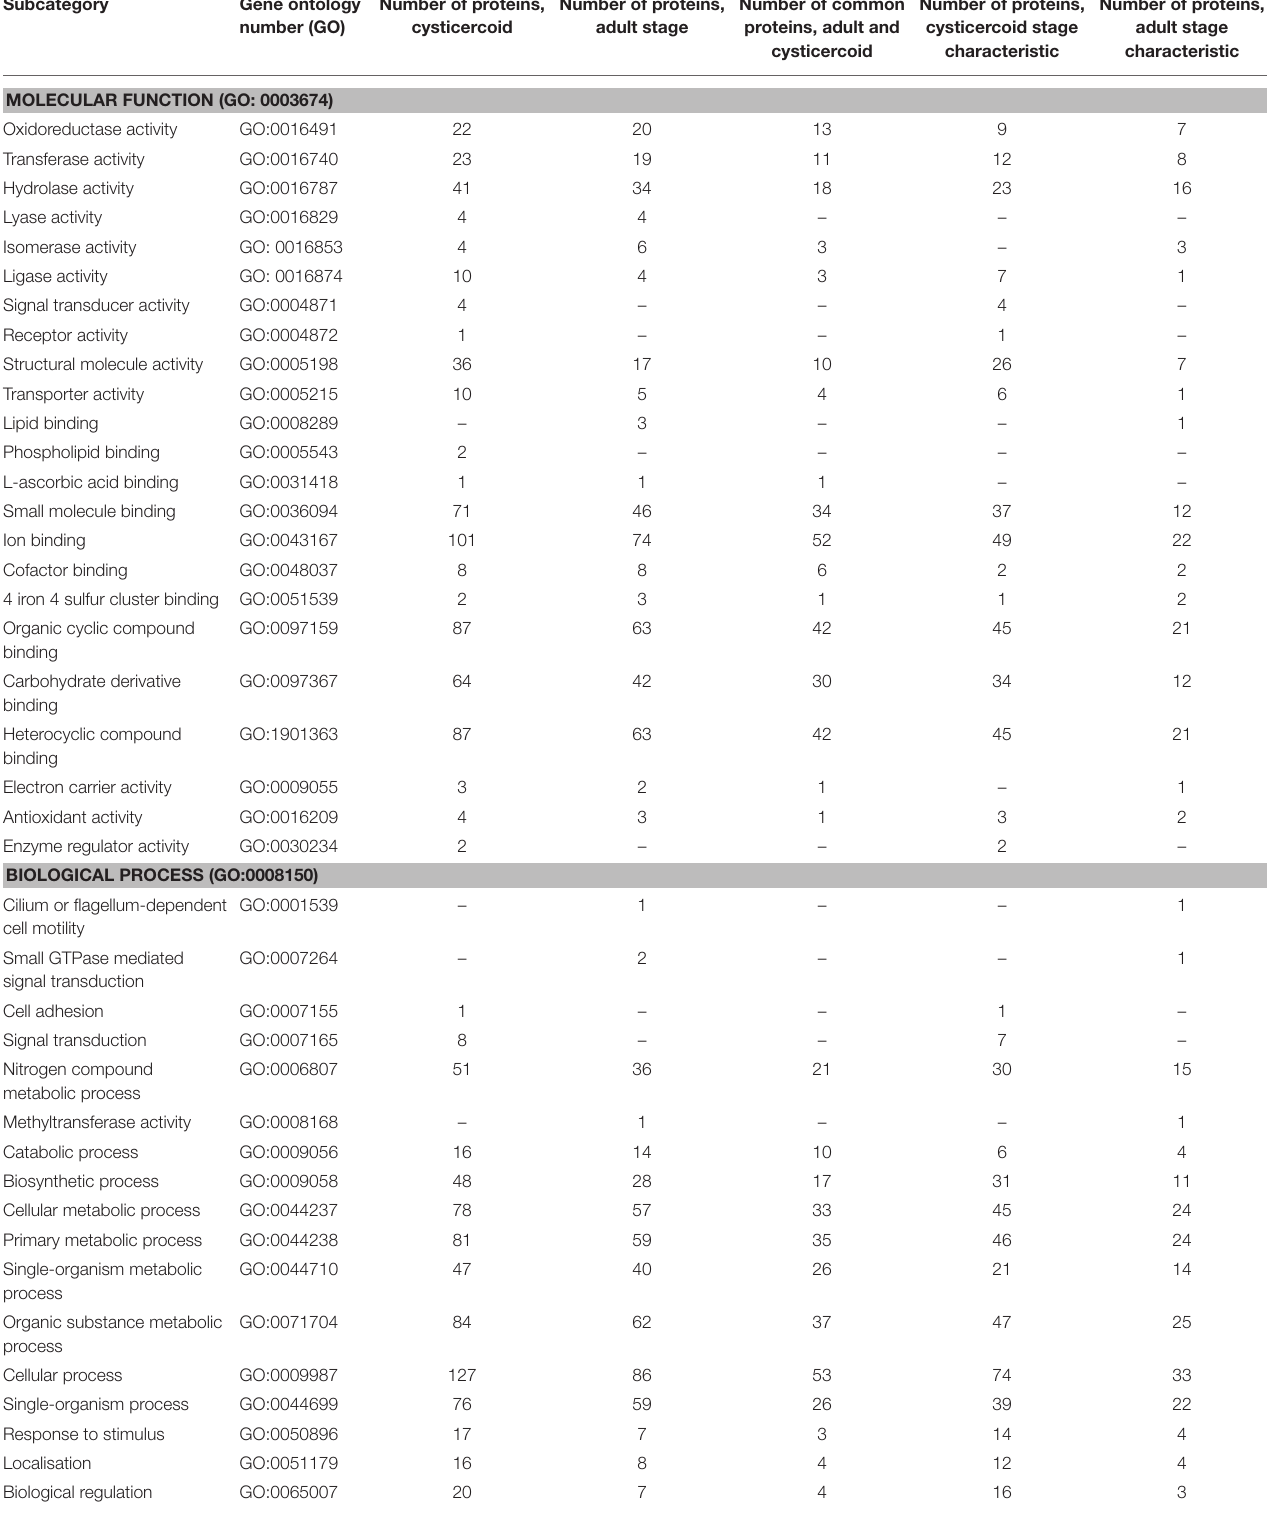
TABLE 2 | Functions of H . diminuta -identified cysticercoid and adult stage proteins according to Gene Ontology (GO) category. Subcategory Gene ontology